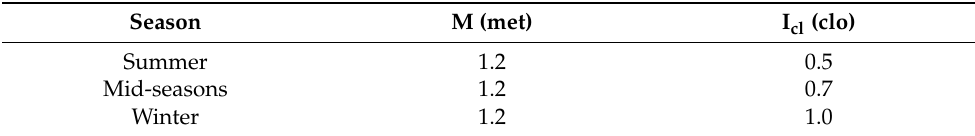
Table 6. Parameters for thermal comfort analysis.